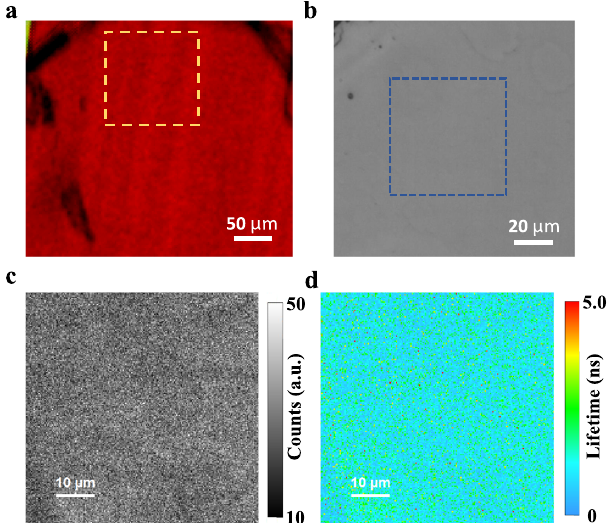
Fig. 4 PL intensity and recombination lifetime mapping for ferroelastic domains. a is polarized optical microscope image with resolved domain patterns, the golden square corresponds to the non-polarized optical microscope image in ( b ); the blue square in ( b ) is the mapping area; c and d are the corresponding PL intensity and PL recombination lifetime mapping results,